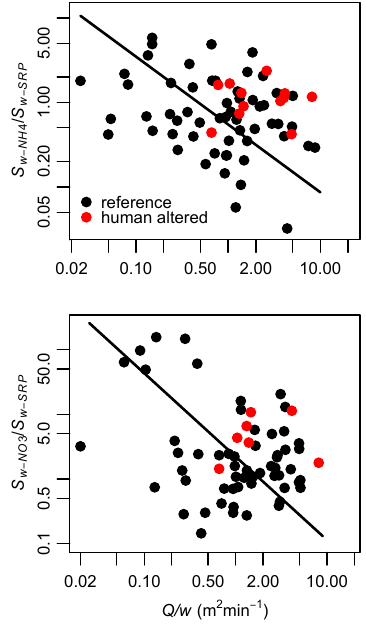
) and ni- Fig. 2. Ratio of ammonium uptake length ( S w − NH 4 ) to soluble reactive phosphorus up- trate uptake length ( S w − NO 3 take length ( S w − SRP ) , declined with specific discharge ( Q/w ) where measured in the same stream. Lines are ordinary least squares for only the reference streams, log 10 ( S w − NH / S w − SRP ) 4 =− 0.25log − 0.20 ( n = 57, p = 0.017, r 2 =0.082) and 10 ( Q/w ) log 10 ( S w − NO / S w − SRP ) =− 0.43log 10 ( Q/w )+0.34 ( n = 57, 3 p = 0.011, r 2